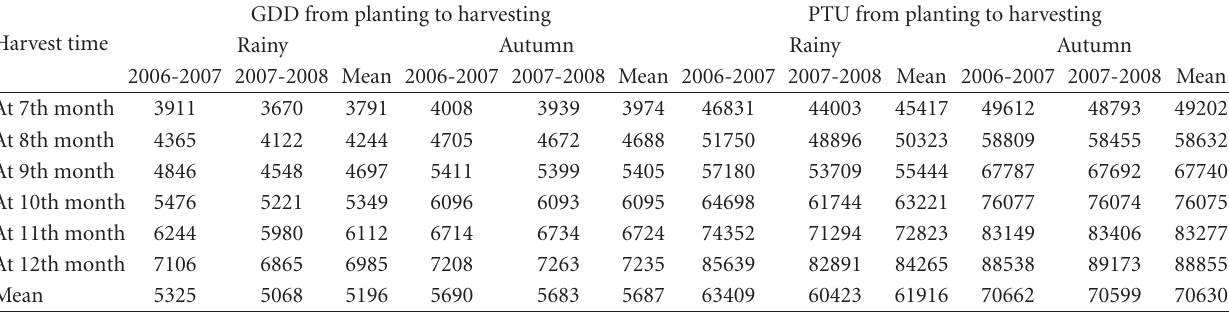
Table 5: Growing degree days (GDDs) and photo thermal units (PTUs) accumulation of Acorus calamus (sweet flag) as influenced by staggered harvesting over two seasons and